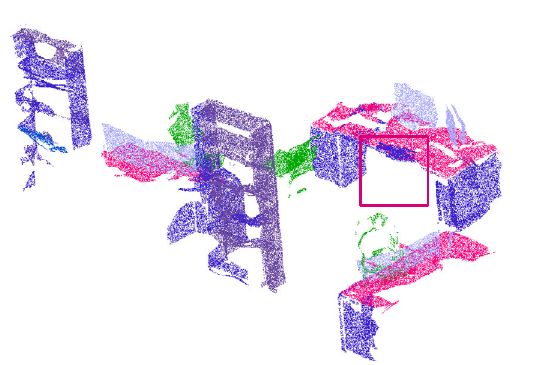
Figure 6. The failure cases in Dataset-2 (part-3).